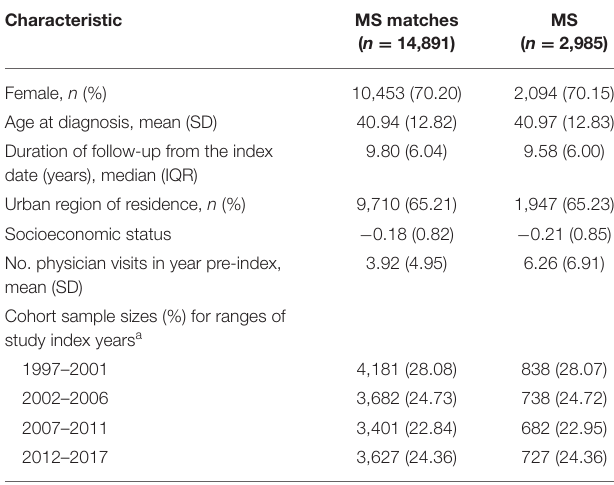
TABLE 1 | Characteristics of incident disease cohorts at the time of diagnosis, and matched cohorts at the matched index date.